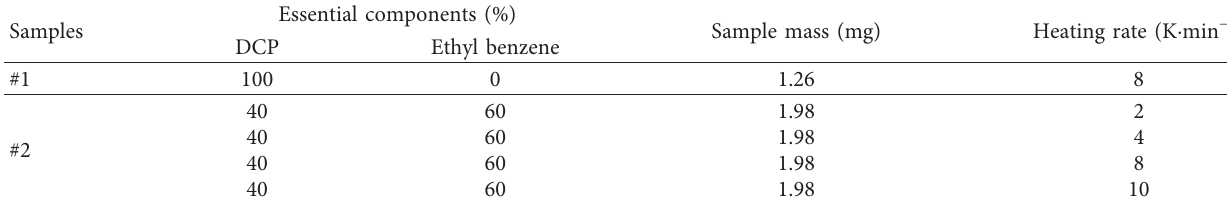
Table 1: Mass in DSC tests.